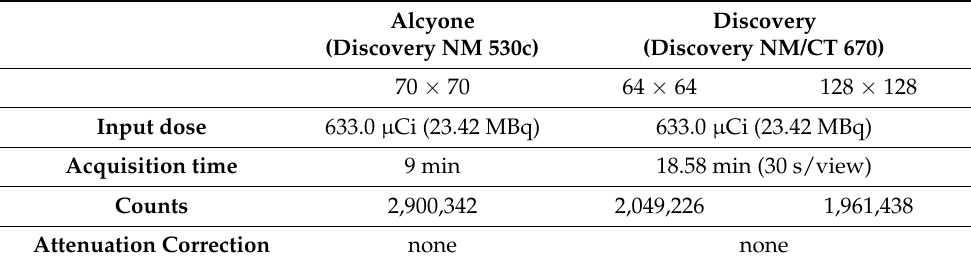
Table 3. Acquisition parameters used for scanning the cardiac